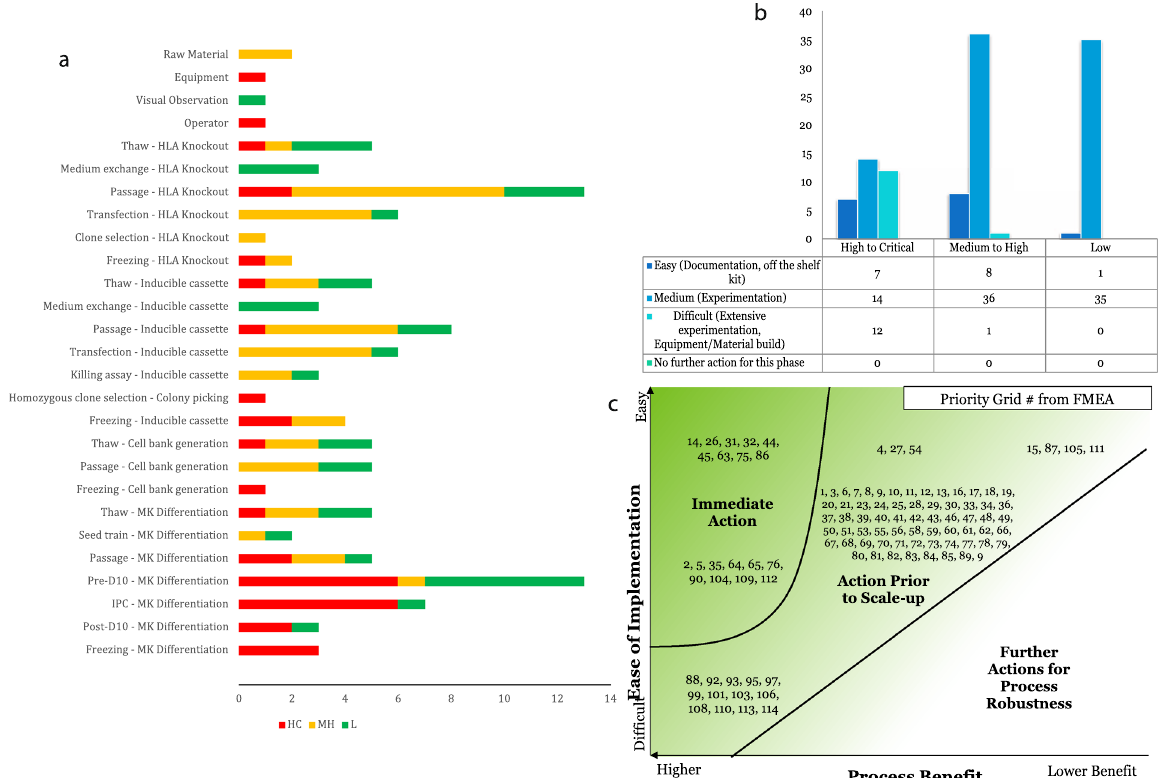
Fig. 3 Failure mode and effect analysis. a Segregation of identi fi ed risks by processing step and Risk Priority Code (RPC). Risks were scored as (L) Low risk, RPN < 40 and Severity < 3, (MH) Medium to High risk, Severity ≥ 3 or RPN ≥ 40 and ≤ 75 or (HC) High to Critical risk, RPN ≥ 75. b Segregation of identi fi ed risks by Risk Priority Code (RPC) score and ease of implementation for proposed mitigation strategies. Risks were scored as in A. Ease of implementation was scored as follows: (1) Documentation/Training/Just do it/Purchase kit. Does not change RPC and/or does not improve, (3) Experimentation/Vendor contact/Technical Agreement/Changes to BMR. Reduces RPC from MH to L and/or results in some improvement in manufacturability, (5) Long-term development/Extensive experimentation/Machining/User-de fi ned kit/Changes to regulatory submissions. Reduces RPC from HC to MH or L and/or results in signi fi cant improvement in manufacturability. c FMEA Priority Number (PN) Grid Map. This chart plots the priority number associated with each identi fi ed risk in relation to the ease of implementation